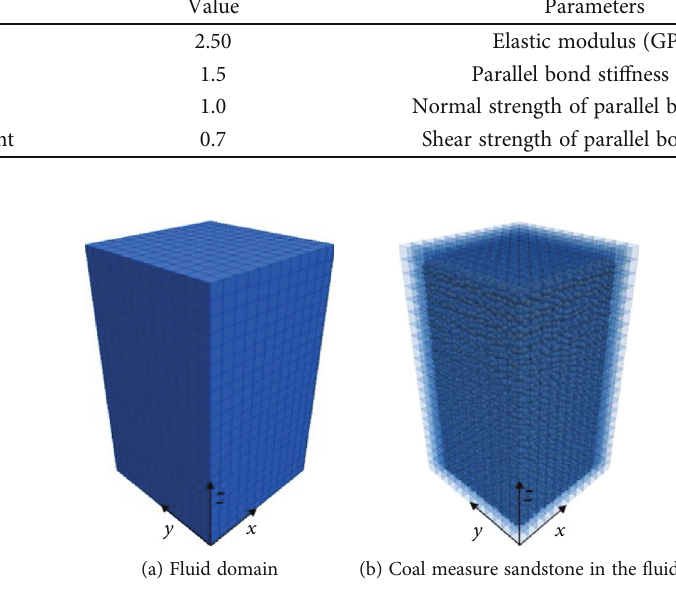
Figure 5: Seepage-creep coupling model by PFC-CFD-PSC method.